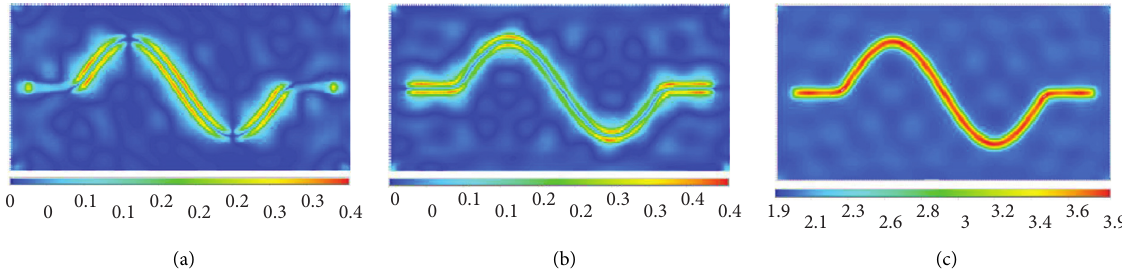
Figure 53: P wave incident (NR � 2, f � 2.0Hz, H � 100m, and C